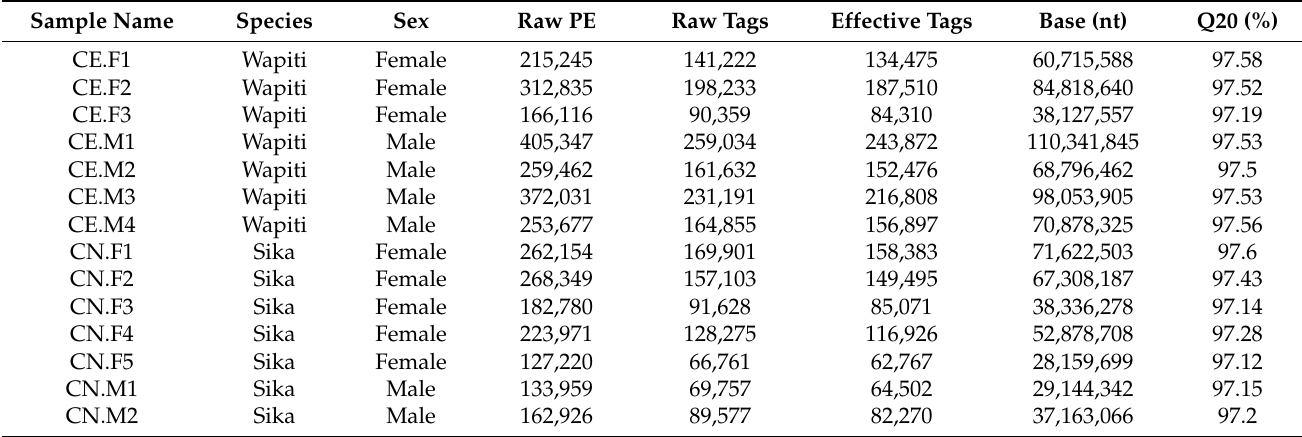
Table 1. Data pre-processing and quality